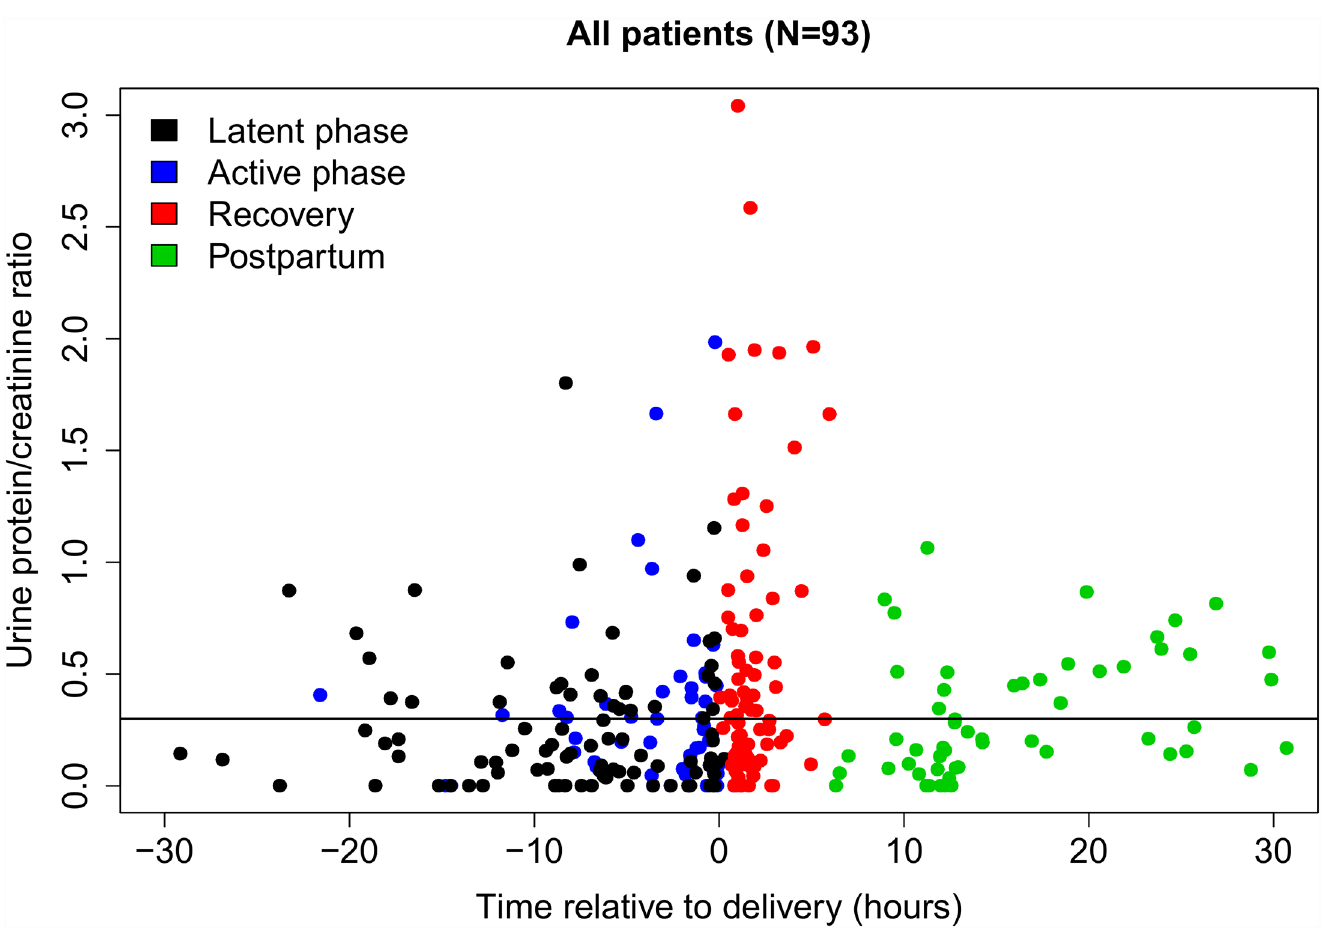
Fig 2. Urine protein/creatinine ratio (uPCR) measurements in all 284 urine samples from 93 women plotted against the timing of the sample collection relative to delivery time. The phase of labor at the time of sample collection is shown for each individual sample by one of four different colors. The horizontal line represents the threshold uPCR value of